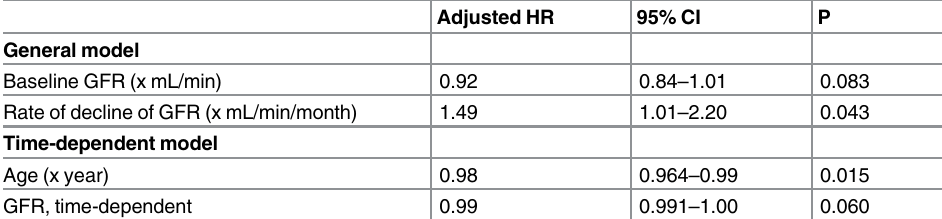
Table 6. Predictors of PD technique failure. General and time-dependent multivariate